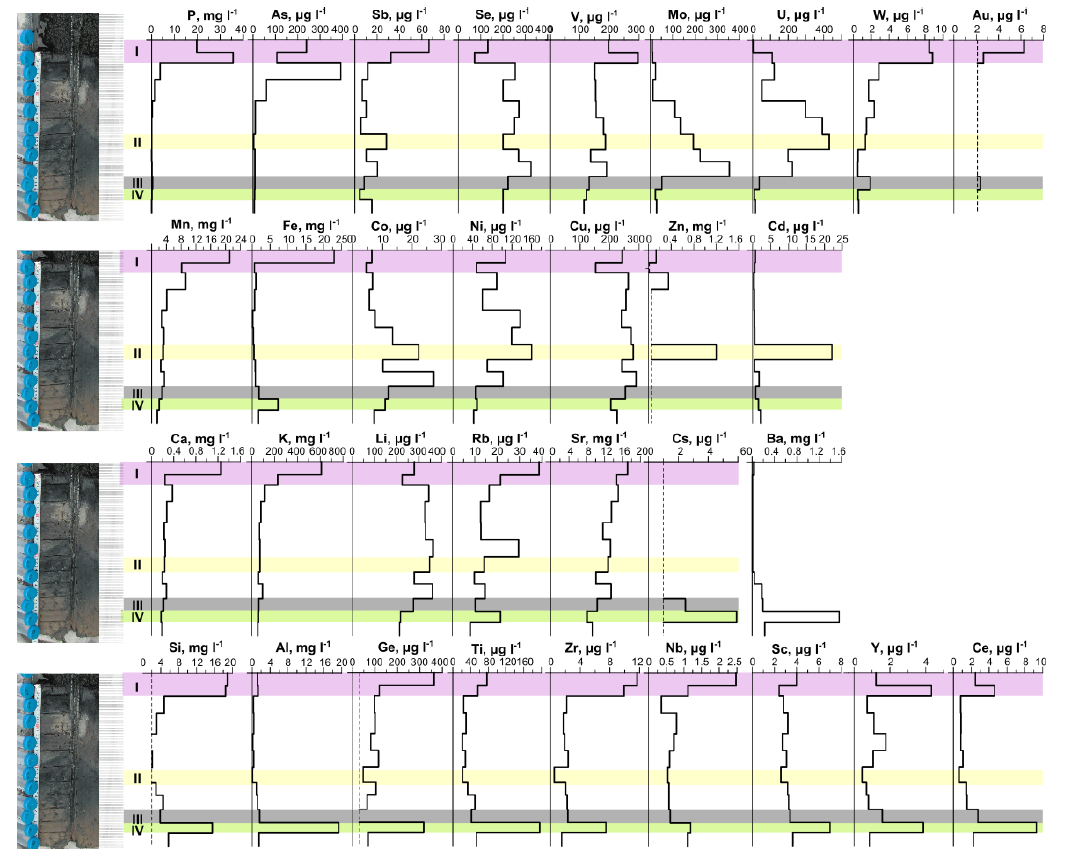
Figure 5. Distribution of elements in the pore solution of the sediment from Lake Solenoe according to 2017 data. ( I ) The layers of the sediment that are characterized by high water abundance and considerable concentrations of C org and C inorg in the solution are highlighted in pink. ( II ) The layer featuring the highest Zn and Cd contents is highlighted in yellow. ( III ) The border of Eh change from ( − ) to (+) is marked in gray. ( IV ) The layer in which the main anions change from Cl − -SO 42 − to Cl − -(SO 42 − ) is highlighted in green.